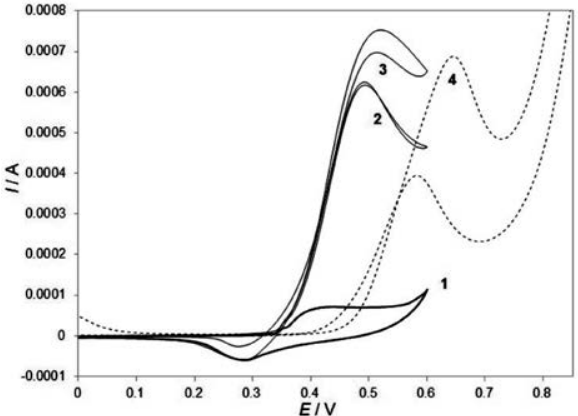
Figure 4. Cyclic voltammograms in the (1) absence and (2) pres- ence of 0.5 M ethanol on Ni, (3) Ni-Cu (4) Cu electrode in 1 M NaOH solution. Scan rate: 10 mV s –1